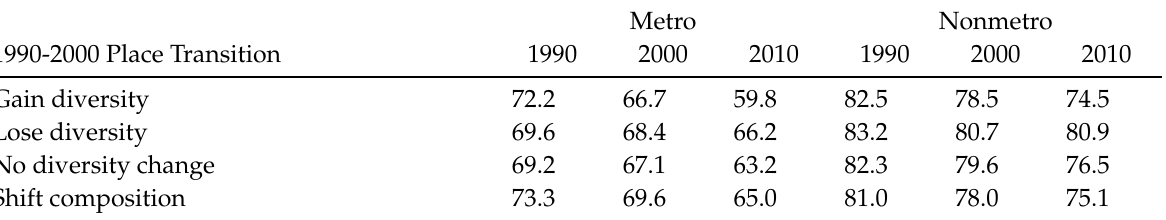
Table 3: Place Transitions and Decade-Specific B-W Indices of Unweighted Dissimilarity ( D ) , 1990-2010